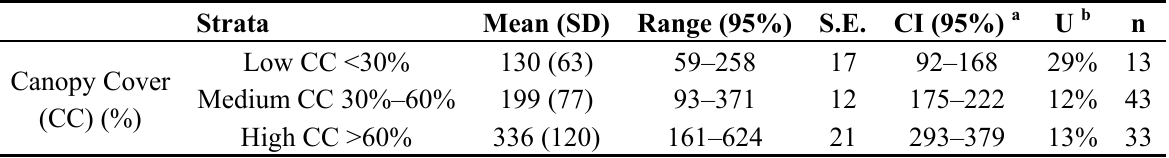
Table 3. Carbon content in arboreal biomass in oak-pine mixed forest in La Primavera México (tCO eq/ha). Mean values and confidence intervals based on the standard error of 2 the mean (S.E.). Strata Mean (SD) Range (95%) S.E. Canopy Cover